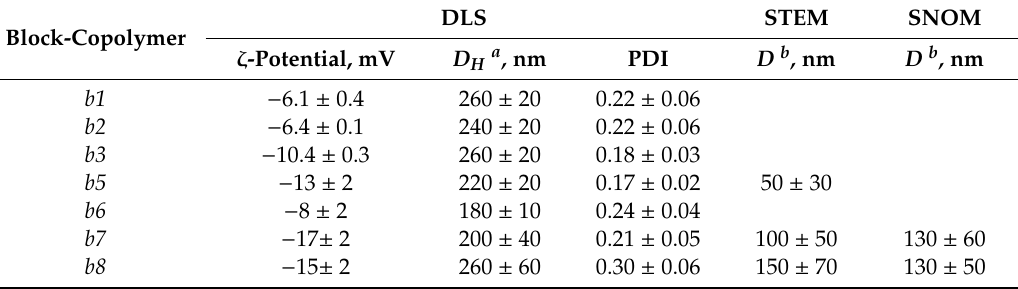
Table 4. Physico-chemical characteristics of self-assembled NPs (in